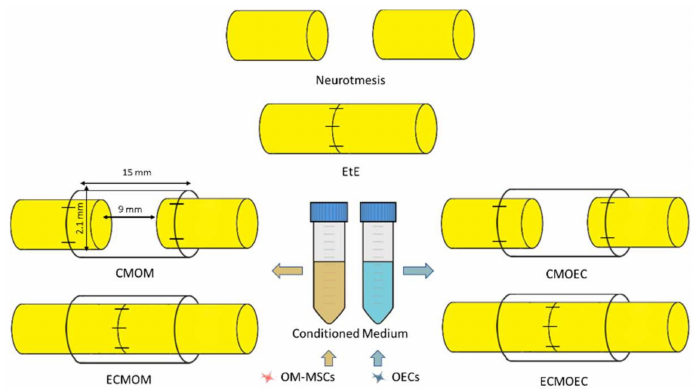
Figure 1. Experimental therapies applied to the sciatic nerve after neurotmesis injury. The applied NGCs are 15 mm long and have an internal diameter of 2.1